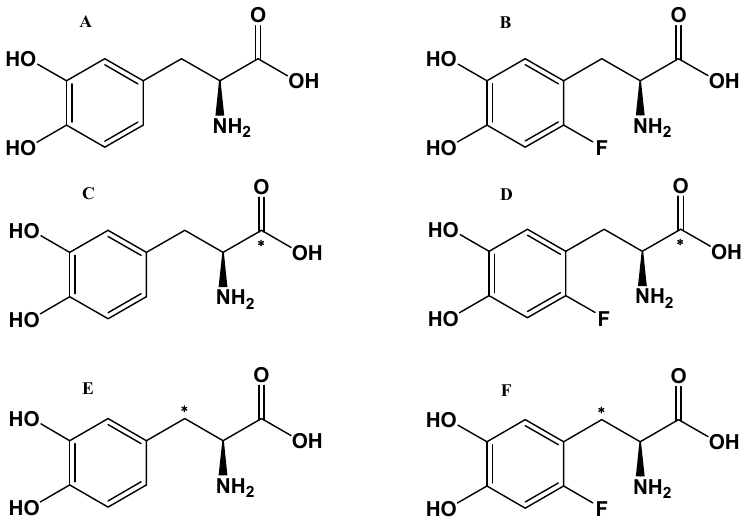
Figure 2. [ 18 F]F-DOPA and [ 11 C]-L-DOPA bio-precursor tracers. ( A ) L-DOPA, ( B ) [ 18 F]F-DOPA, ( C ) [ 11 C]-L-DOPA, ( D ) [ 11 C]F-DOPA, ( E ) [ β - 11 C]-L-DOPA, and ( F ) [ β - 11 C]F-DOPA. * indicates labeling in β -position or in the carboxylic position. Similarly to L-DOPA, [ 18 F]F-DOPA can cross the BBB by L-amino acid